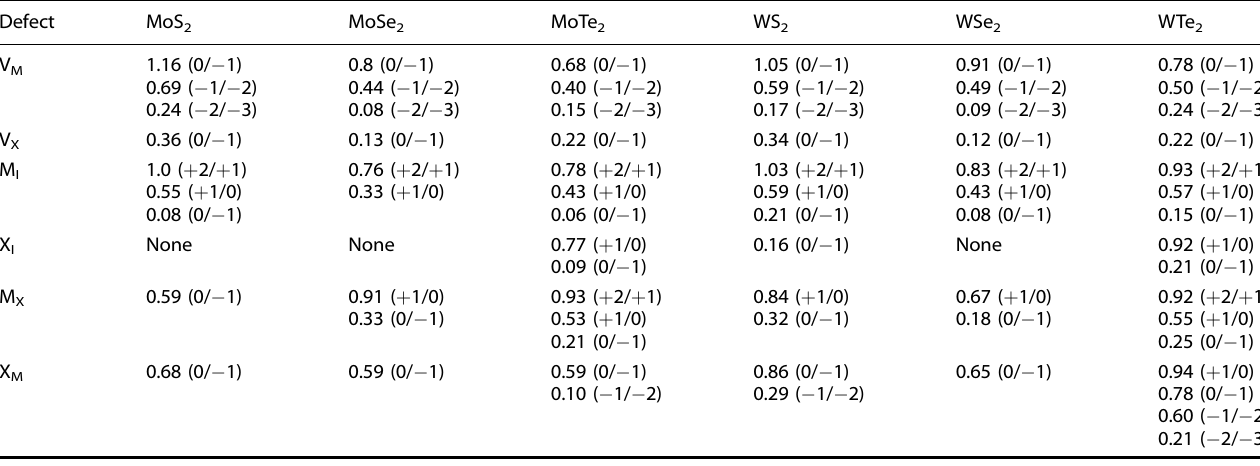
Table 2. Charge transition levels of defects identi fi ed in Fig. 1. Defect